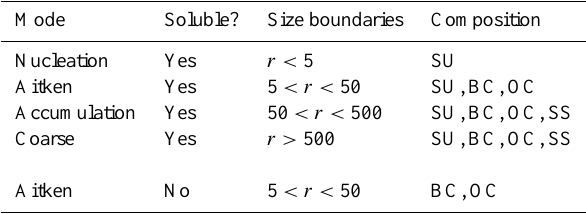
Table 1. Solubility, size boundaries, and composition of the five modes in the GLOMAP-mode aerosol scheme. Components are sul- phate (SU), black carbon (BC), organic carbon (OC) and sea-salt (SS). r is the geometric mean radius of the aerosol particles, includ- ing hygroscopic growth for soluble modes, in